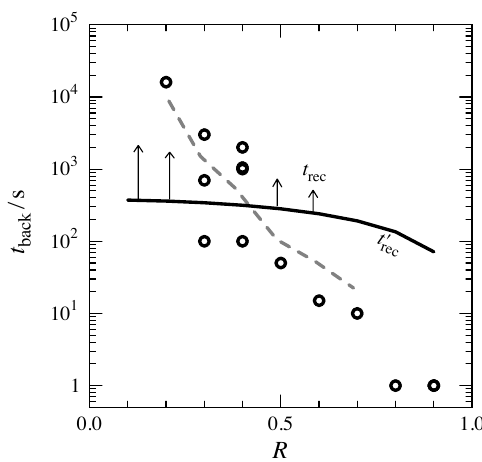
Figure 4. Times t back for anelastic back flow (circles, from Figure 3e) compared to lower bound t (cid:48) rec of times t rec for dynamic recovery toward the new qs state as function of R for σ r,0 = 275MPa; dashed line corresponds to dashed line in Figure